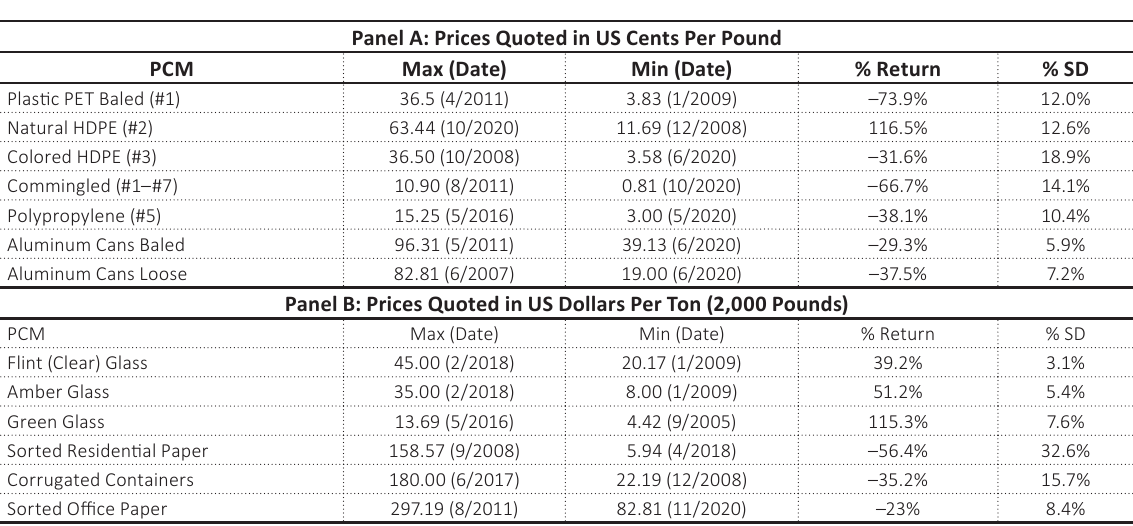
Table 1. Summary statistics on monthly PCM